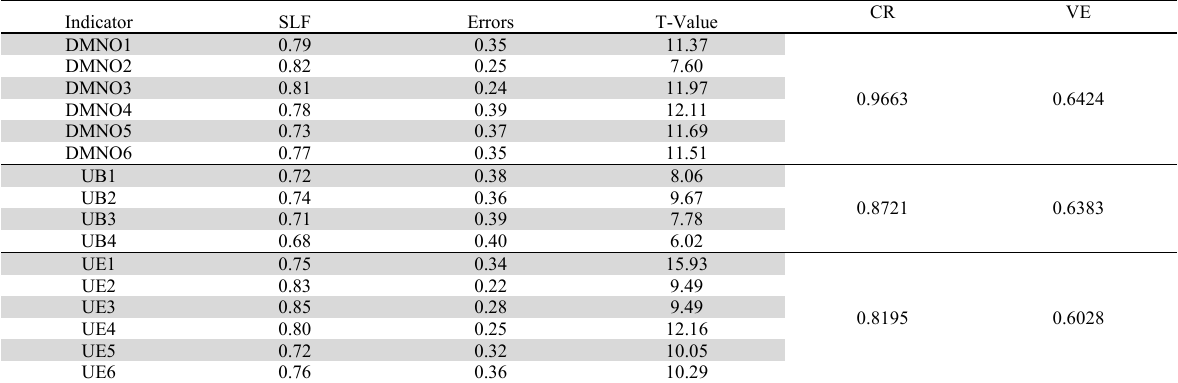
Result of Validity and Reliability